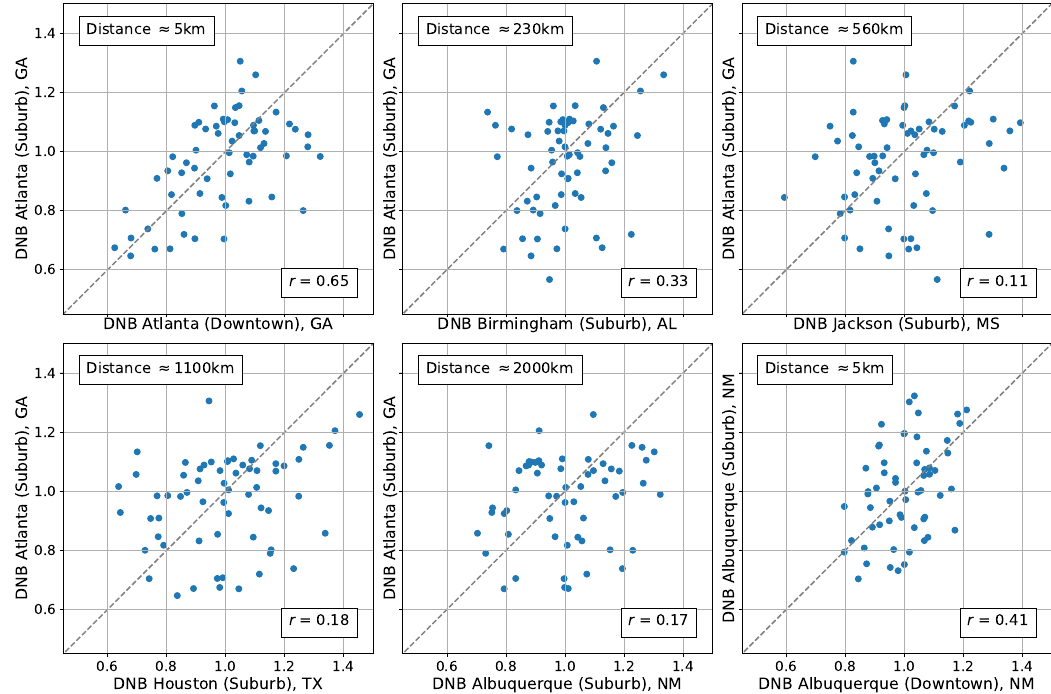
Figure 7. Monthly radiance relative to the median of all months is shown for pairs of sites at different distances. The first five plots compare sites to the suburban site in Atlanta, Georgia, the final plot is for two locations in Albuquerque. The first and final plots compare urban to suburban radiance in a single city, while the other plots compare pairs of suburban